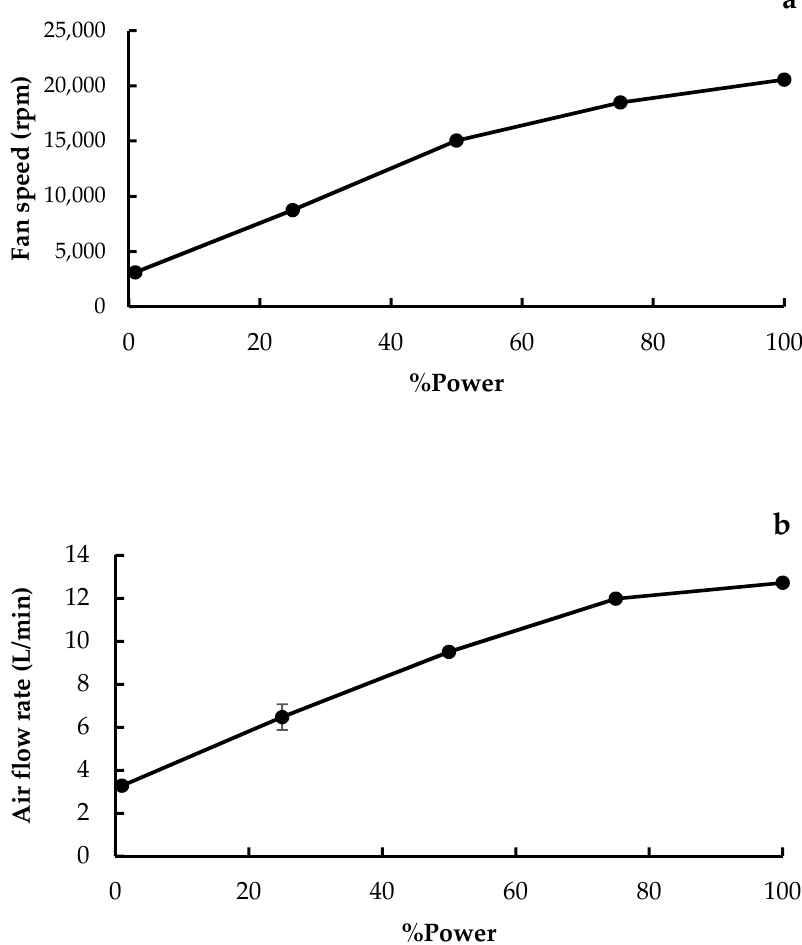
Figure 7. Relation of %power to ( a ) fan speed and ( b ) airflow rate of the add-on